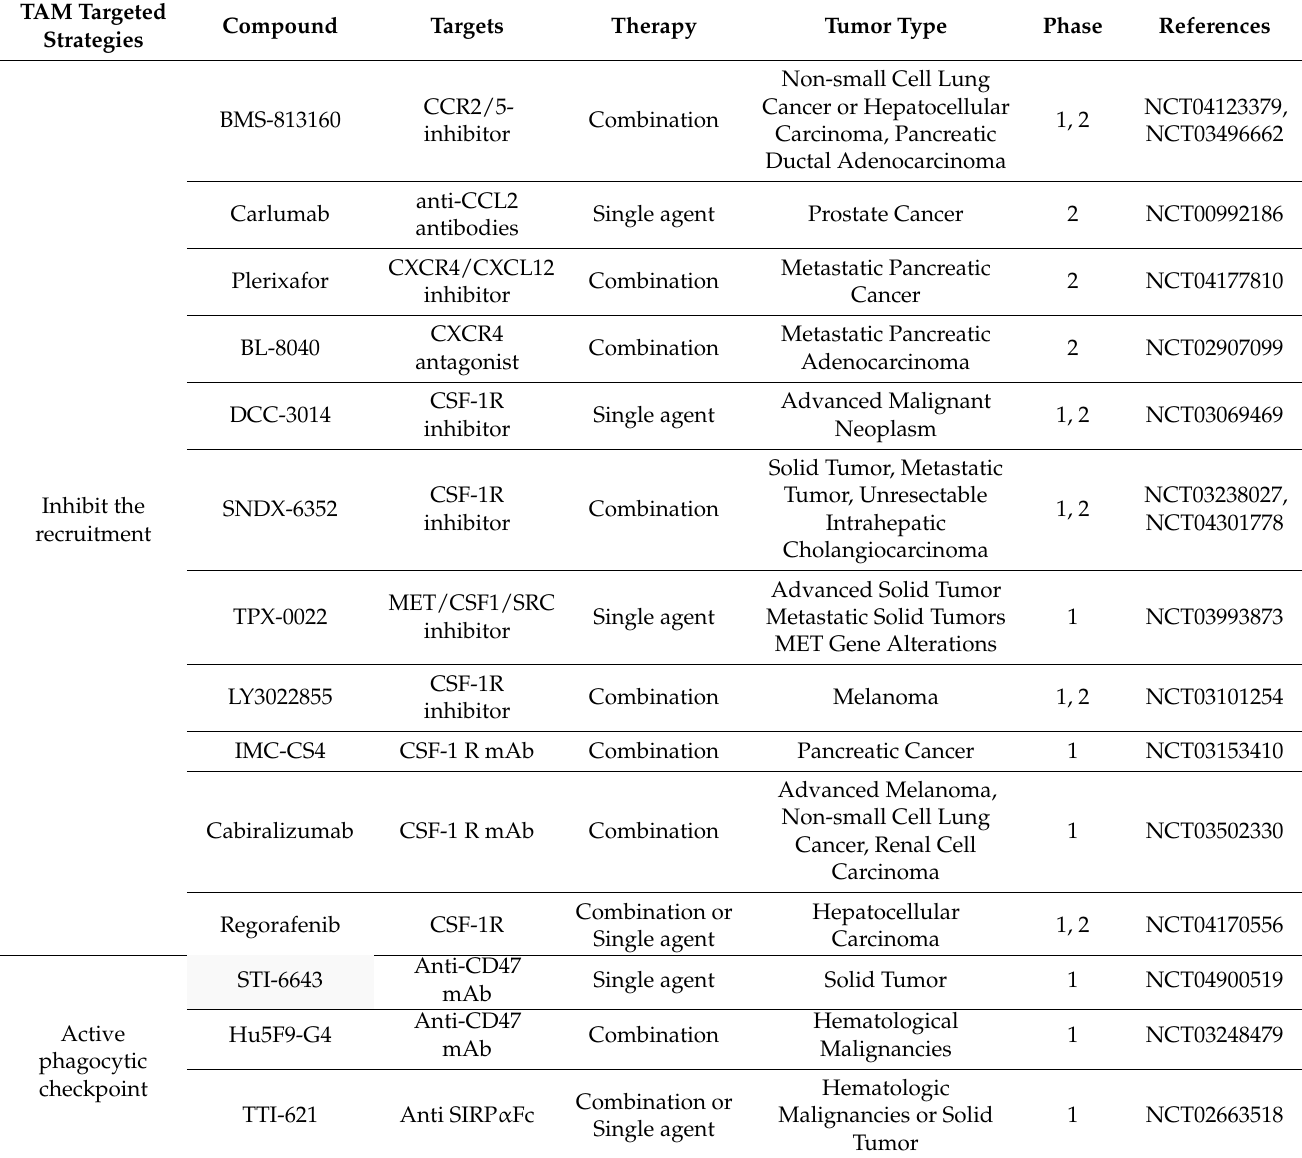
Table 1. TAM-targeted therapy in clinical